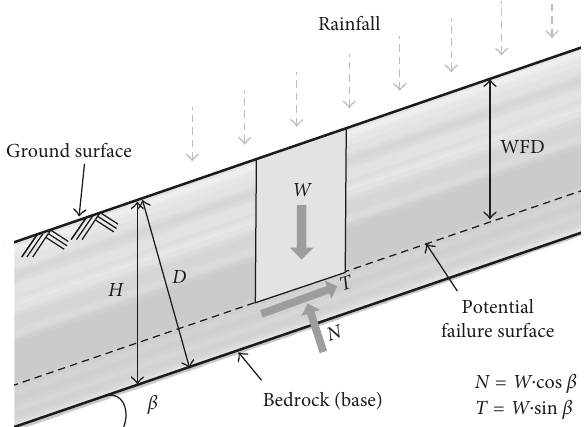
Figure 2: Infinite slope analysis model.